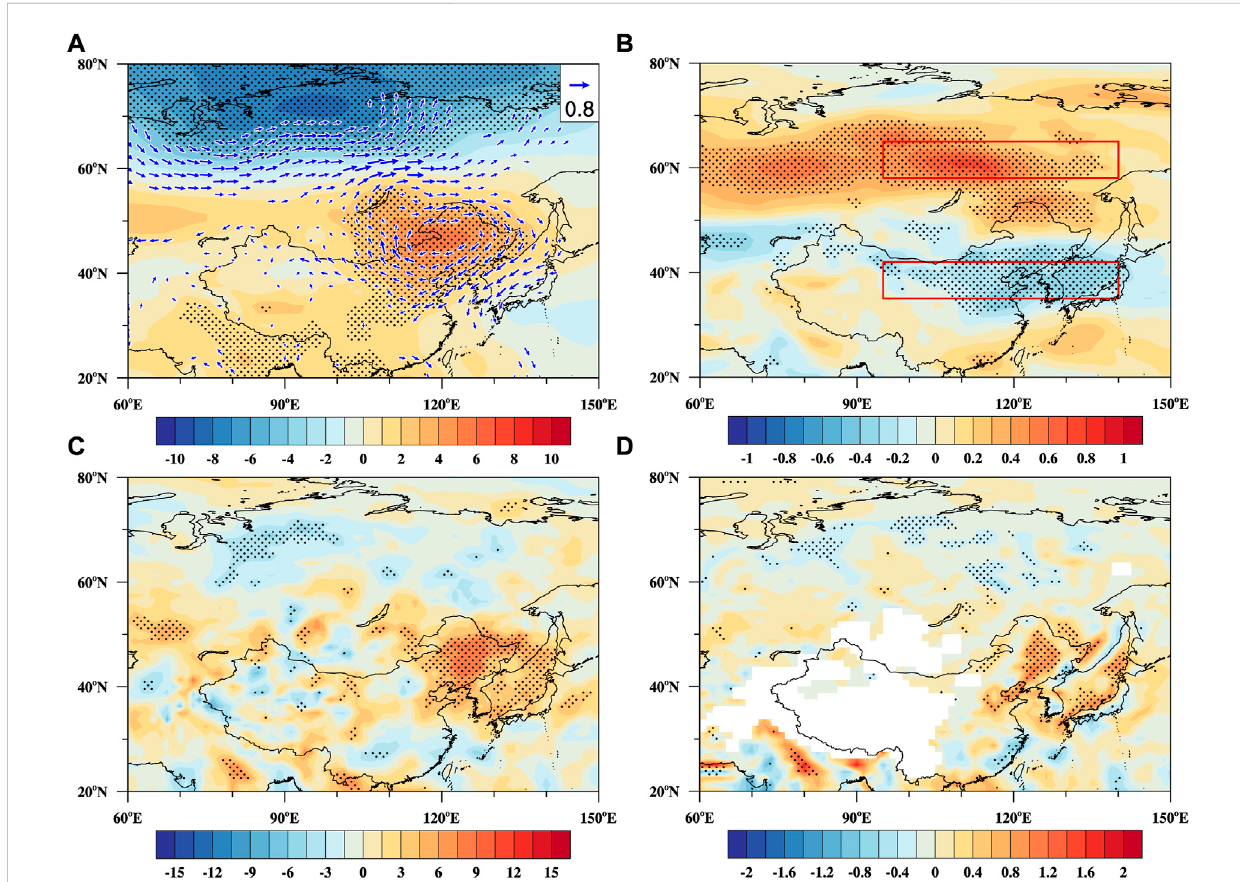
FIGURE 3 Regressionsof summer anomalous (A) 850 hPa geopotential height (shading; unit: gpm) and horizontal wind (vector; unit: m s − 1 ), (B) 850 hPa zonal wind (unit: m s − 1 ), (C) 500 hPa vertical velocity (unit: 10 – 3 Pa s − 1 ), and (D) moisture divergence vertically integrated from the surface to 850 hPa (unit: 10 – 5 kg m − 2 s − 1 )againstthenormalizedCDDAindexduring1960 − 2019.Stippledregionsandvectorsindicatethattheanomaliesaresigni fi cantatthe95% con fi dence level. The red boxes in (B) indicate the regions used to de fi ne the zonal wind index